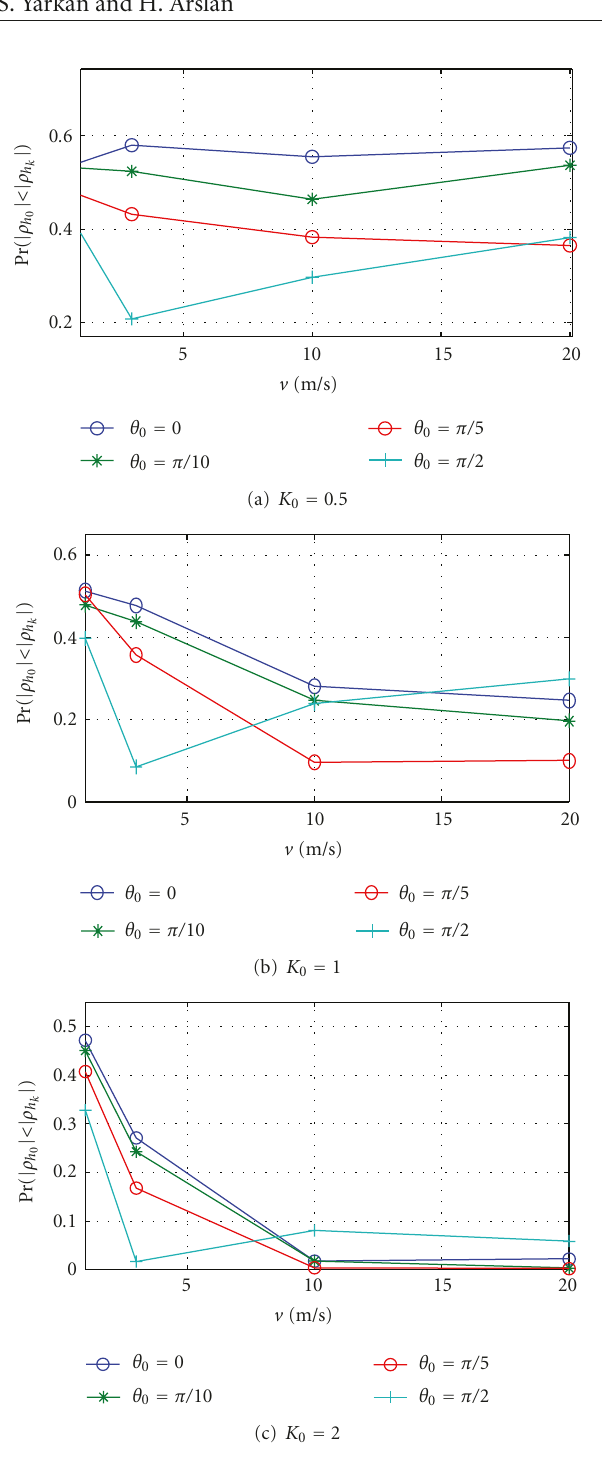
( Δ t 1 ) | 2 < ρ h ( Δ t 1 ) | 2 versus the s d